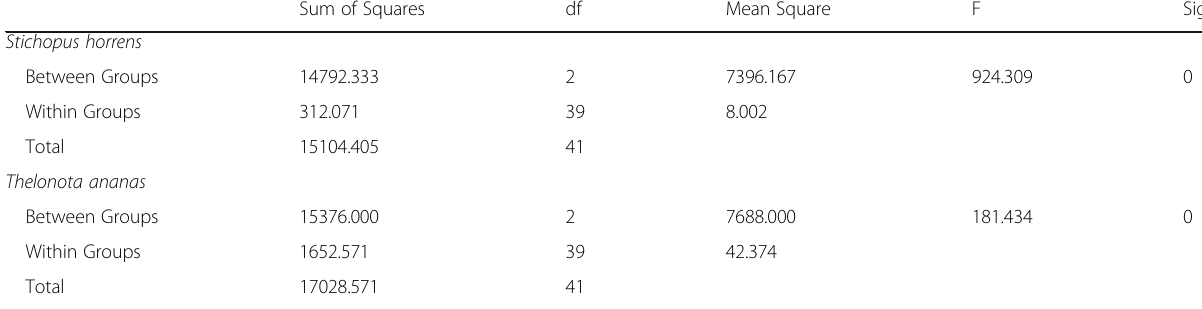
Table 7 The analysis of one way ANOVA for different species during the period of study (2000, 2006 and 2016) (Continued) Sum of